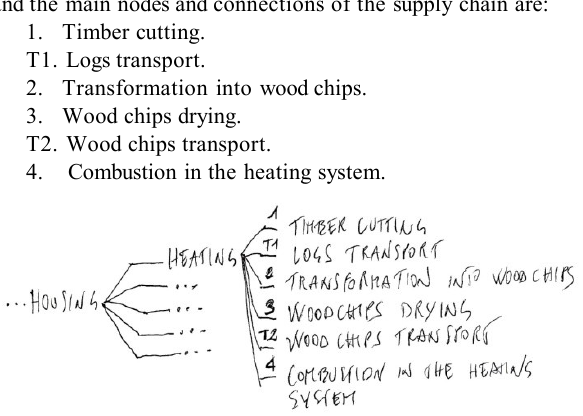
Figure 3. Simplified Impact Geography of the consumption categories in figure 2, in the IG the territory is made up of different areas, private, local and global.